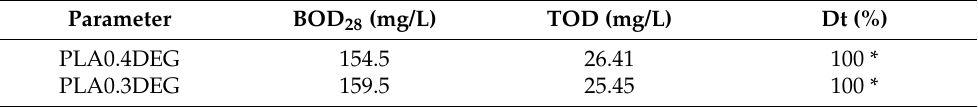
Table 5. Results of susceptibility to biodegradation of eco-polyols based on waste PLA. Parameter